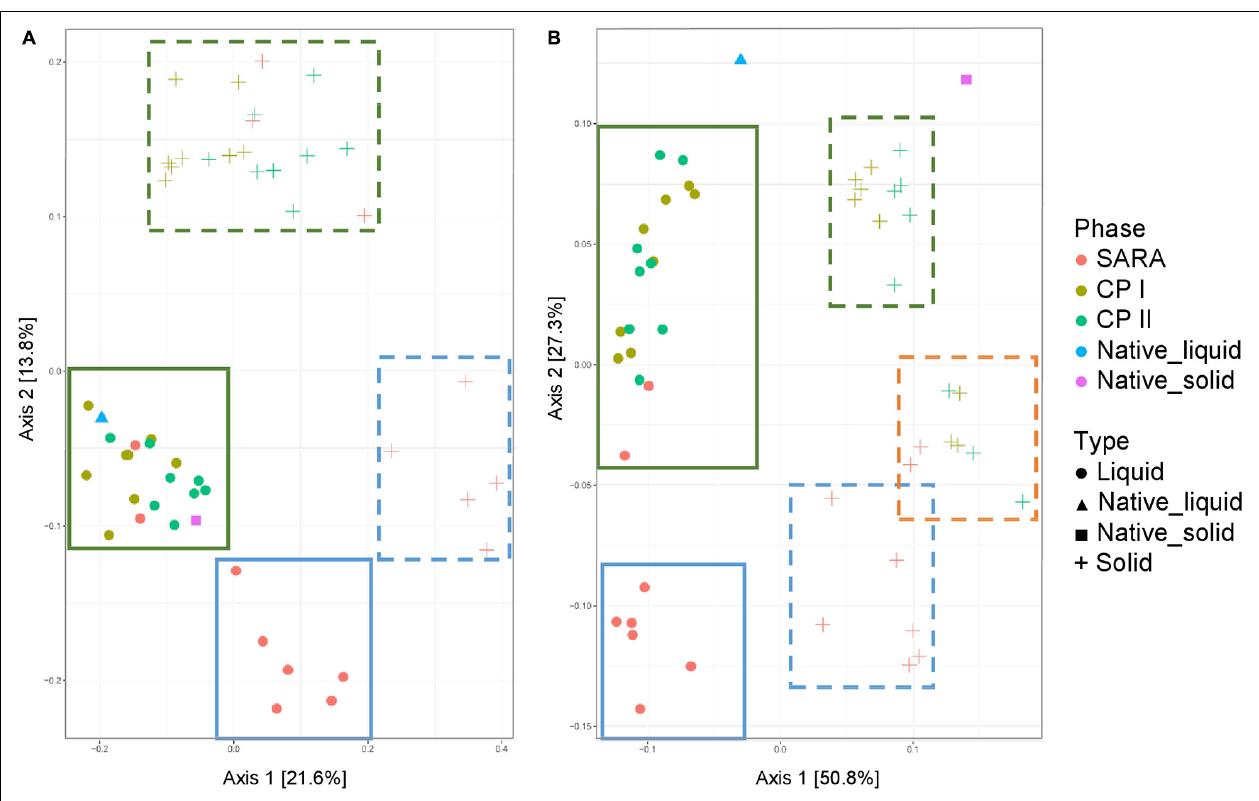
FIGURE 5 | Unweighted (A) and weighted (B) UniFrac distances of samples analyzed by Illumina MiSeq (V4) imply a clustering of treatment groups during control period I (CP I, colored in green) and control period II (CP II, colored in turquoise), and during SARA conditions (SARA, colored in red) for the liquid (dots) and solid phase (crosses). Clusters in the liquid phase are marked with boxes with solid lines, clusters within the solid phase are marked by boxes with broken lines.